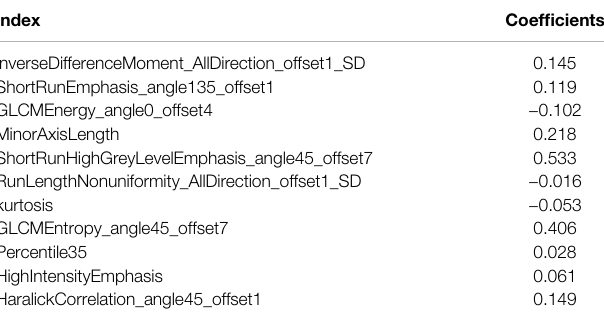
TABLE 5 | 11 features selected by the LASSO